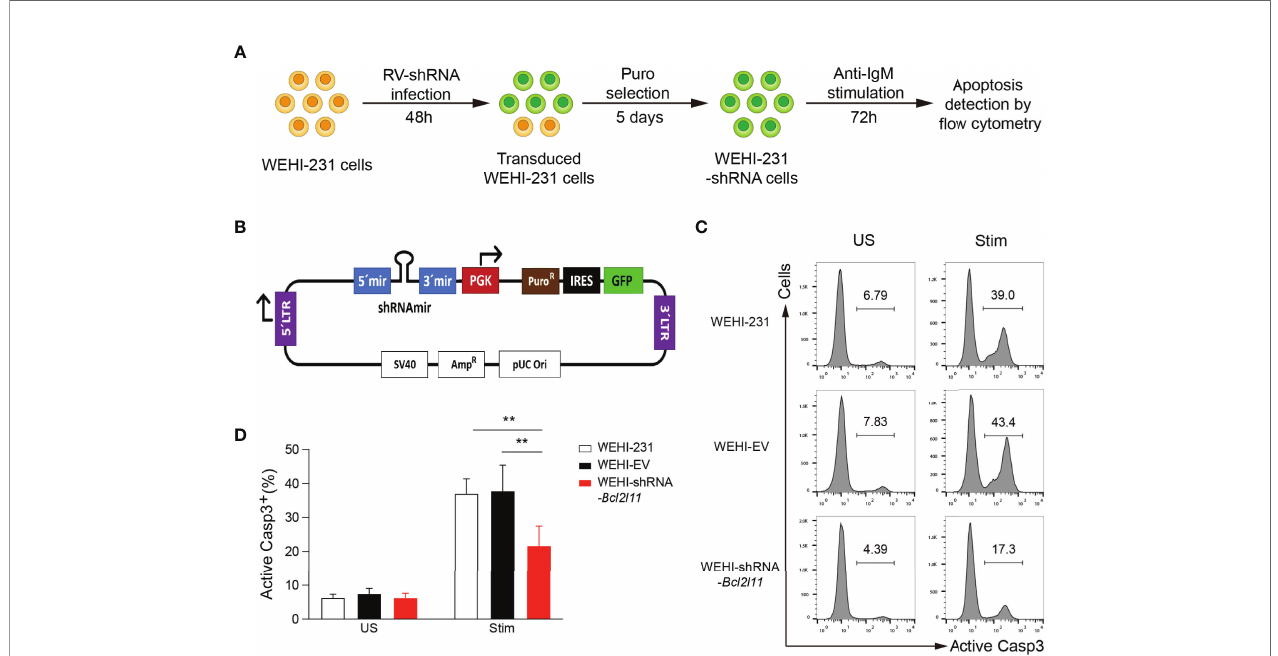
FIGURE 1 | In vitro functional screen platform. (A) Screen strategy outline. WEHI-231 cells were transduced with retroviruses encoding shRNAs. After 48 hours, transduced cells were selected with puromycin for 5 days, stimulated with anti-IgM for 72 hours, stained for active caspase 3 (Casp3), and analyzed by fl ow cytometry. (B) Scheme of the TransOMIC library pMLP vector including the shRNA and puromycin selection cassettes. (C) Flow cytometry histograms showing apoptosis of control non-transduced WEHI-231, WEHI-EV (empty vector) and WEHI – shRNA- Bcl2l11 cells stimulated for 72 hours with 2µg/ml anti-IgM (Stim) or left unstimulated (US), assessed by staining of active caspase 3. (D) Frequency of active caspase-3-positive (Casp3 + ) cells among total cells as in (C) . The results are representative of 4 independent experiments. Data are represented as mean + SD. Statistical analysis was performed with a one-way ANOVA test with **P <